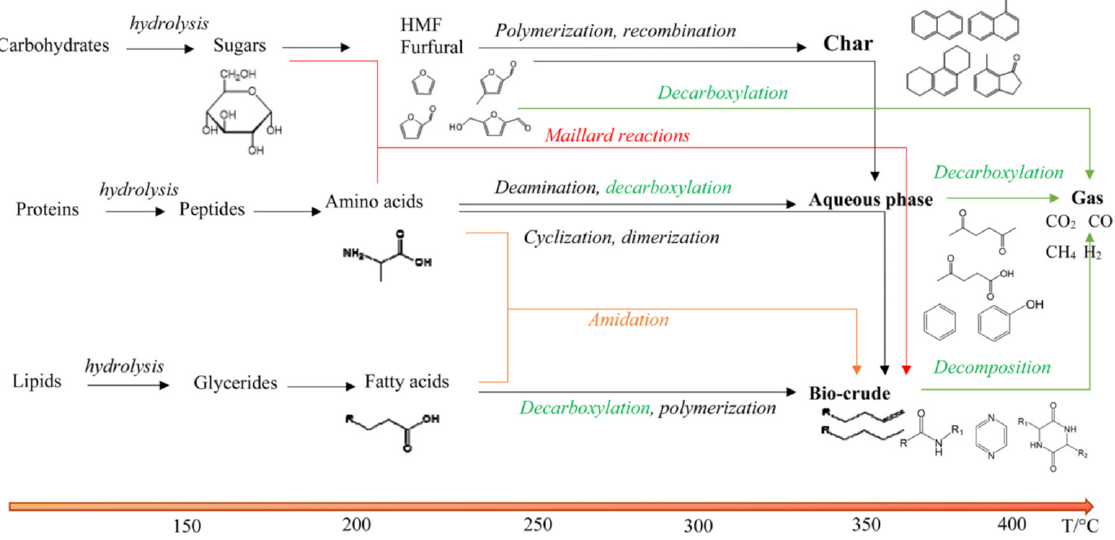
Figure 1. General reaction network for thermal disintegration of sewage sludge, [5] (Elsevier Ltd., CC BY ‐ NC ‐ ND license).